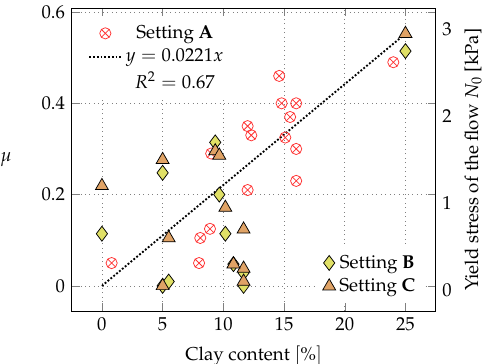
Figure 7. Correlation between back-calculated dry Coulomb friction values µ and percentage of clay content. The back-calculated yield stress of the flow values based on settings B and C show a similar trend (cf. Tables 1 and